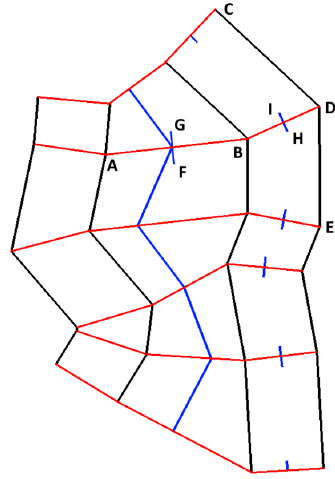
Figure 20. The stream, the banks, the overbanks, and the sections formed.